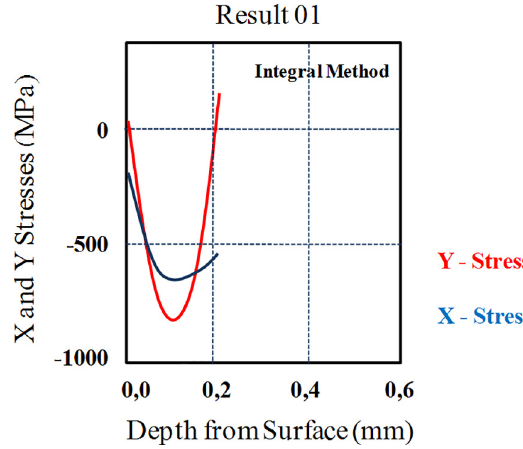
Figure 5. Residual stresses profile X and Y for the test 1